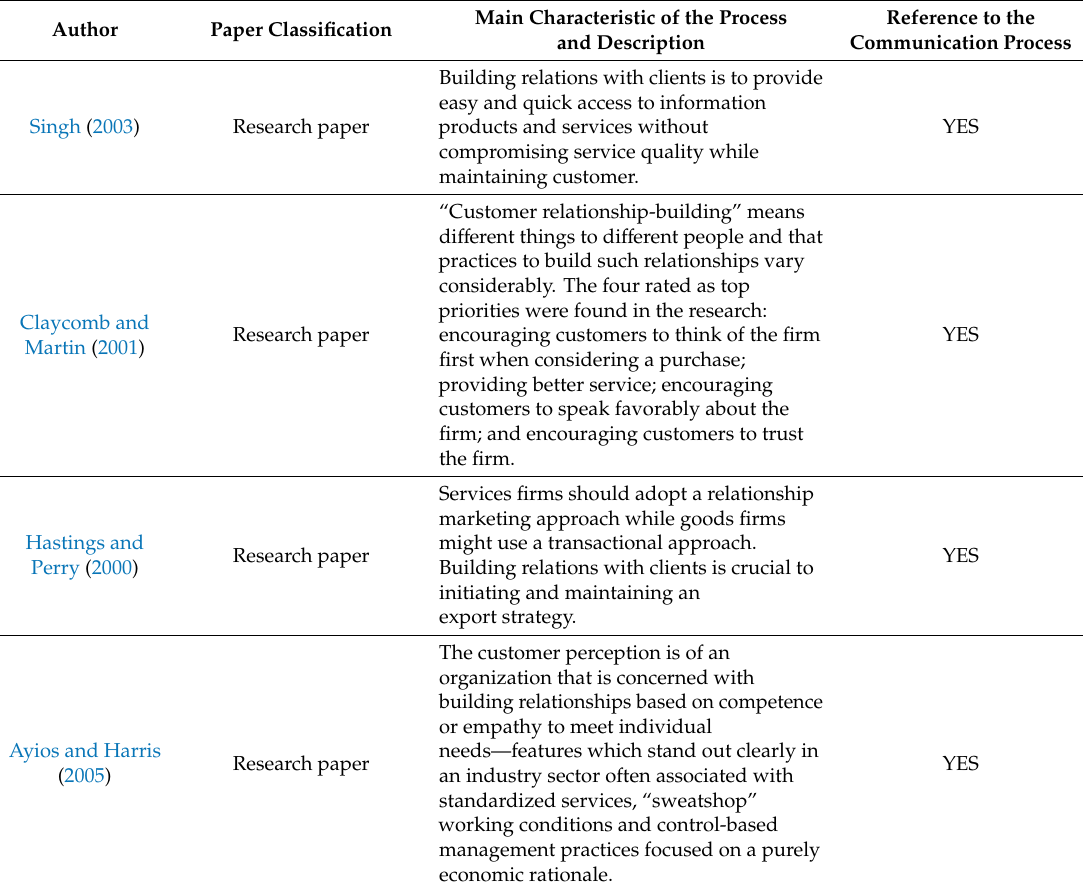
Table 2. Selected definitions of “building relations with clients” due to